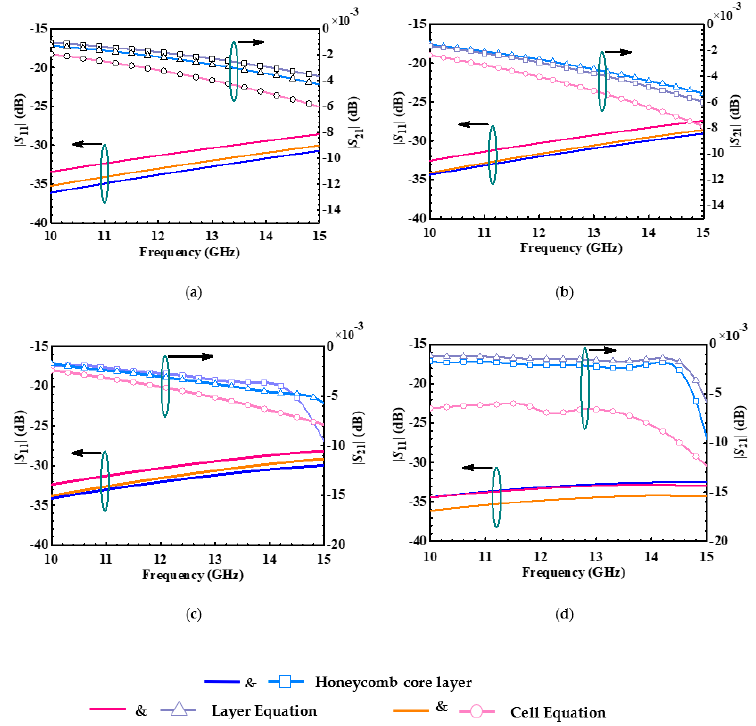
Figure 7. The comparison of scattering parameters of the honeycomb core layer, cell EM equation, and layer EM equation in flat state and under different states, ( a ) planar, ( b ) 30° bending, ( c ) 60° bending, and ( d ) 90° bending.